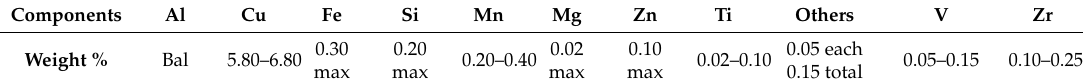
Table 1. Chemical composition in weight percentage (aluminum alloy AA-2219).